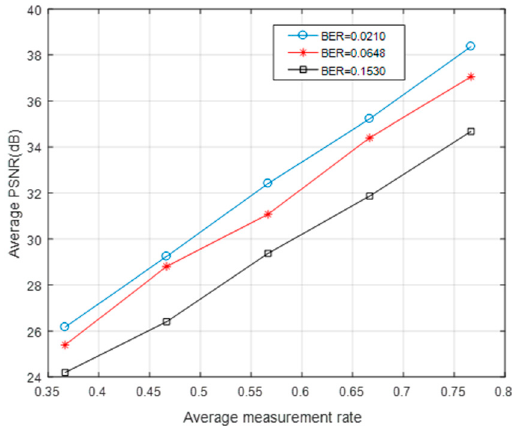
Figure 11. The AMR-PSNR performances for the “foreman”.